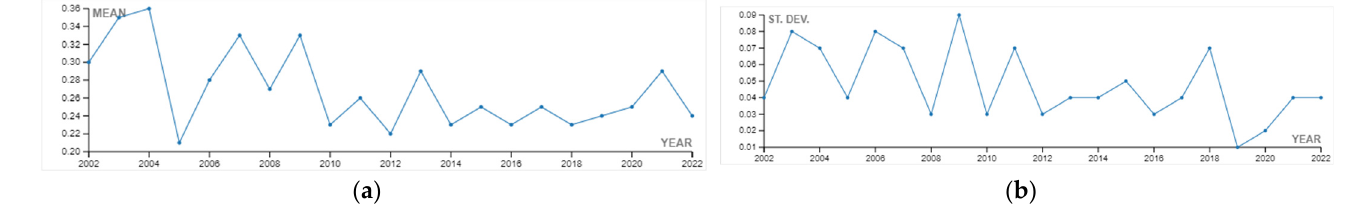
Figure 8. Yearly plotted NDVI values from the MODIS/006/MOD13Q1 ‘NDVI’ collection, clipped on the AOI.shp, time interval: 20 years (2002–2022); ( a ) yearly mean NDVI values; ( b ) yearly standard deviation NDVI values.